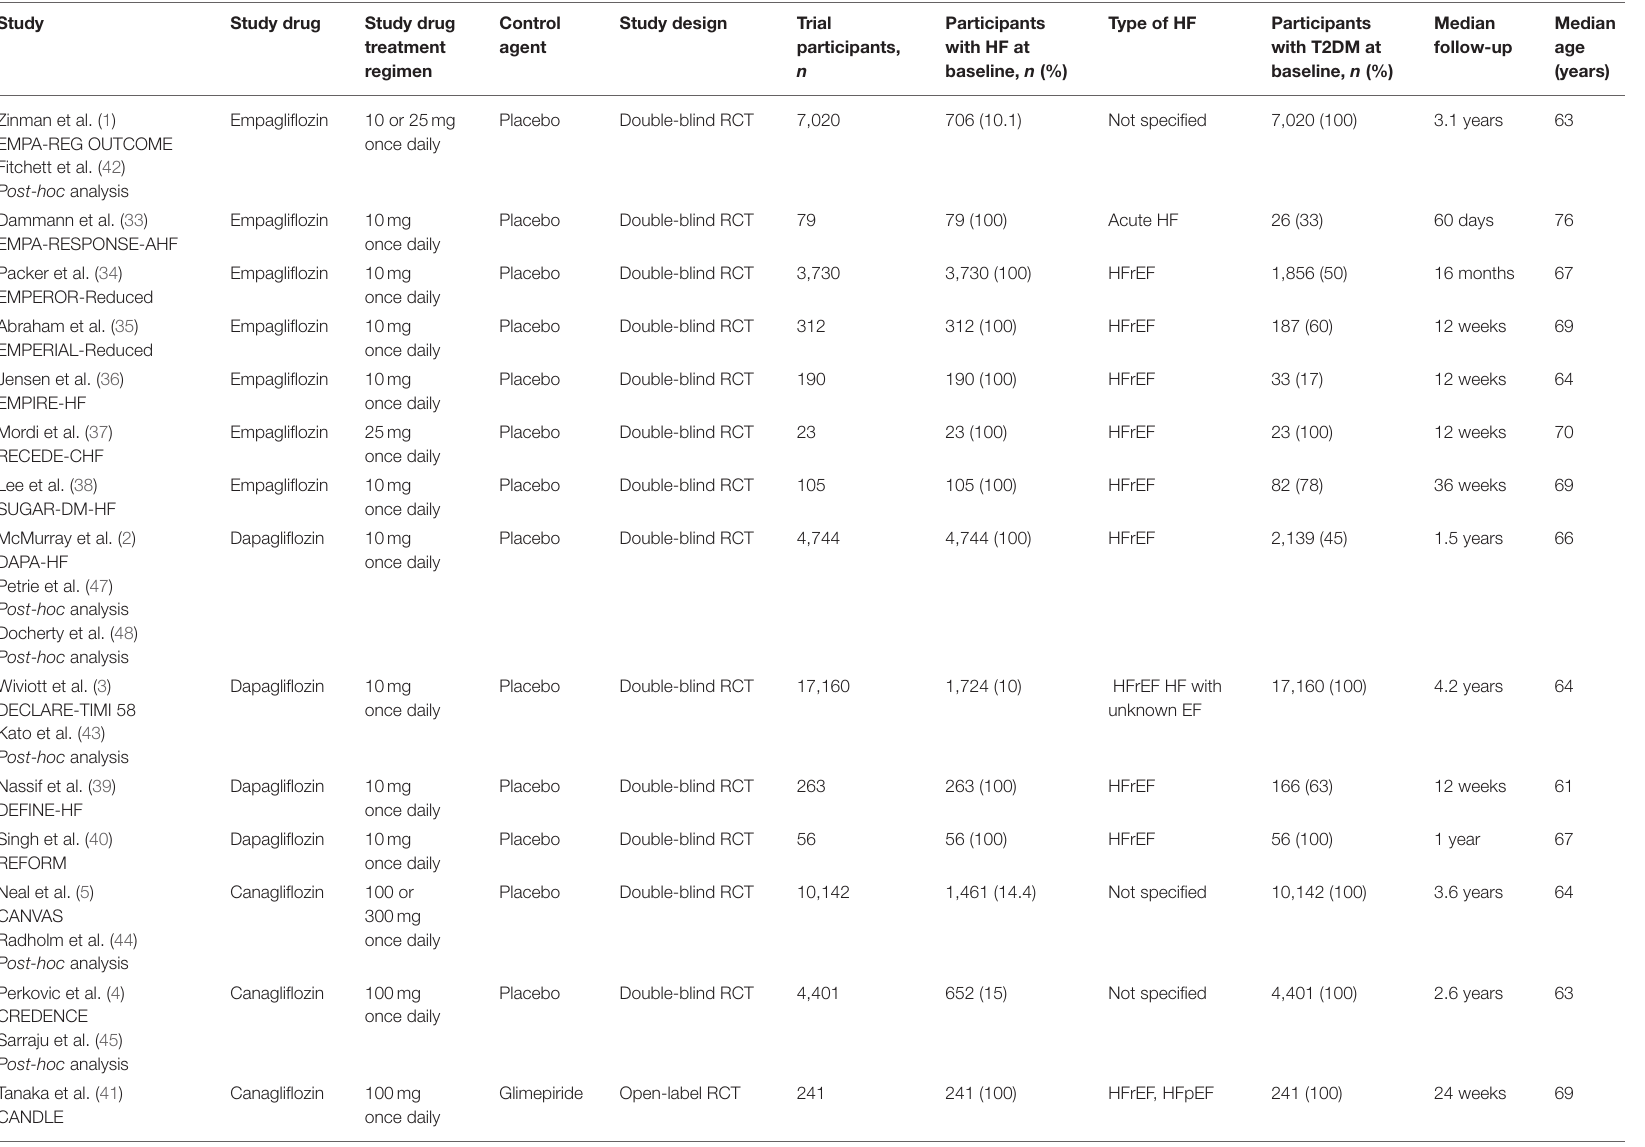
TABLE 1 | Characteristics of the included